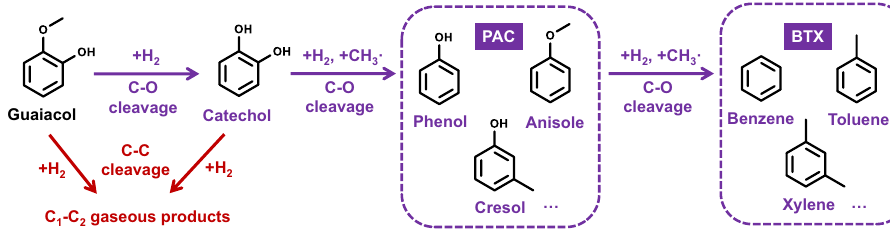
Fig. 3 Reaction pathways of guaiacol hydrodeoxygenation. Only relevant products observed in this study are included